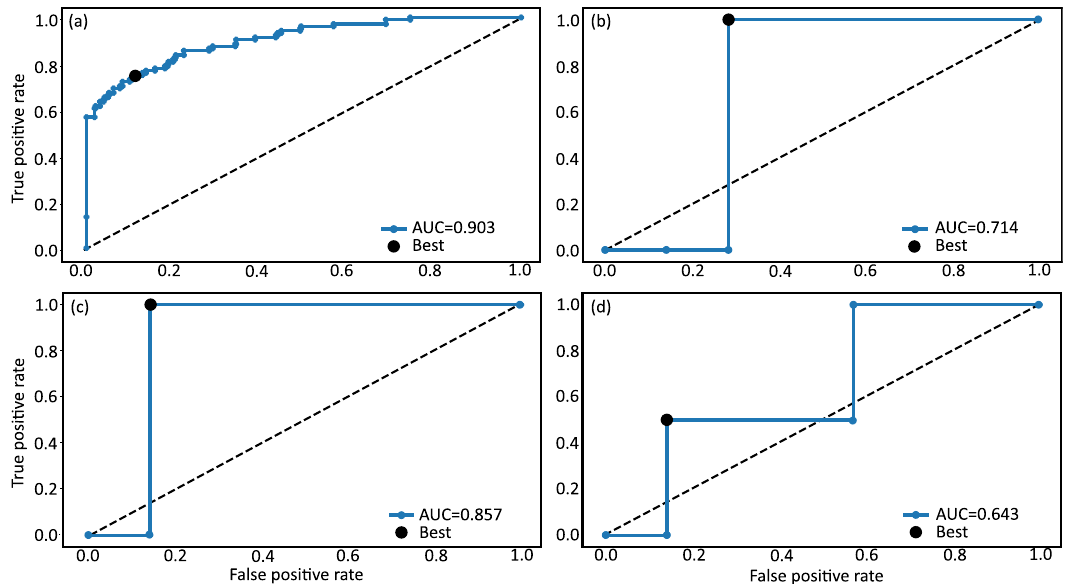
Fig. 3 Representative ROC curves for response phenotype classi fi cation. a imbalanced simulated clinical data set, b application of pre-trained C-SBINN directly to ex-vivo data before the transfer learning step, c ex-vivo data set with transfer learning, and d ex-vivo data set without transfer learning. Displayed curves were selected from the 10-fold cross validation to approximately coincide with the mean AUC, see Table 3. Best g-mean score is highlighted on all